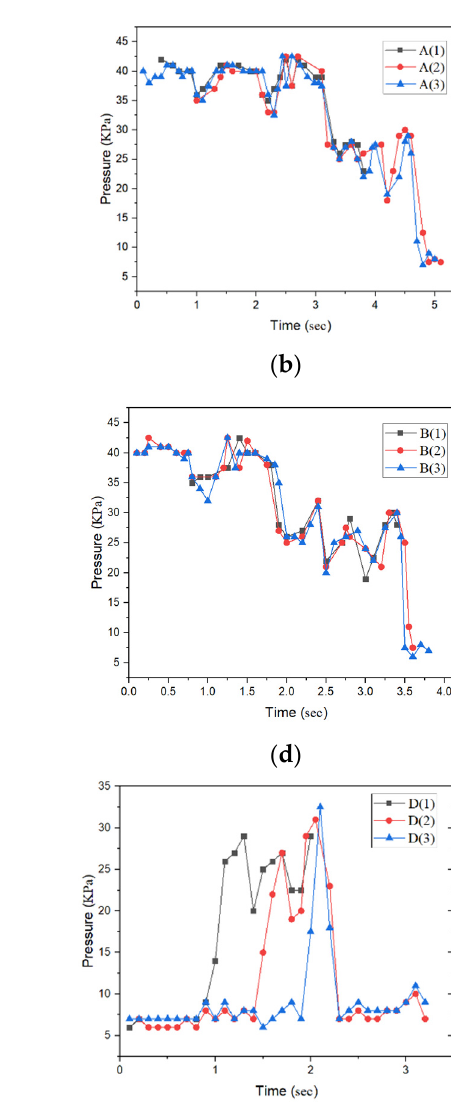
Figure 30 . Double-cabin robot model. Figure 30. Double-cabin robot model.